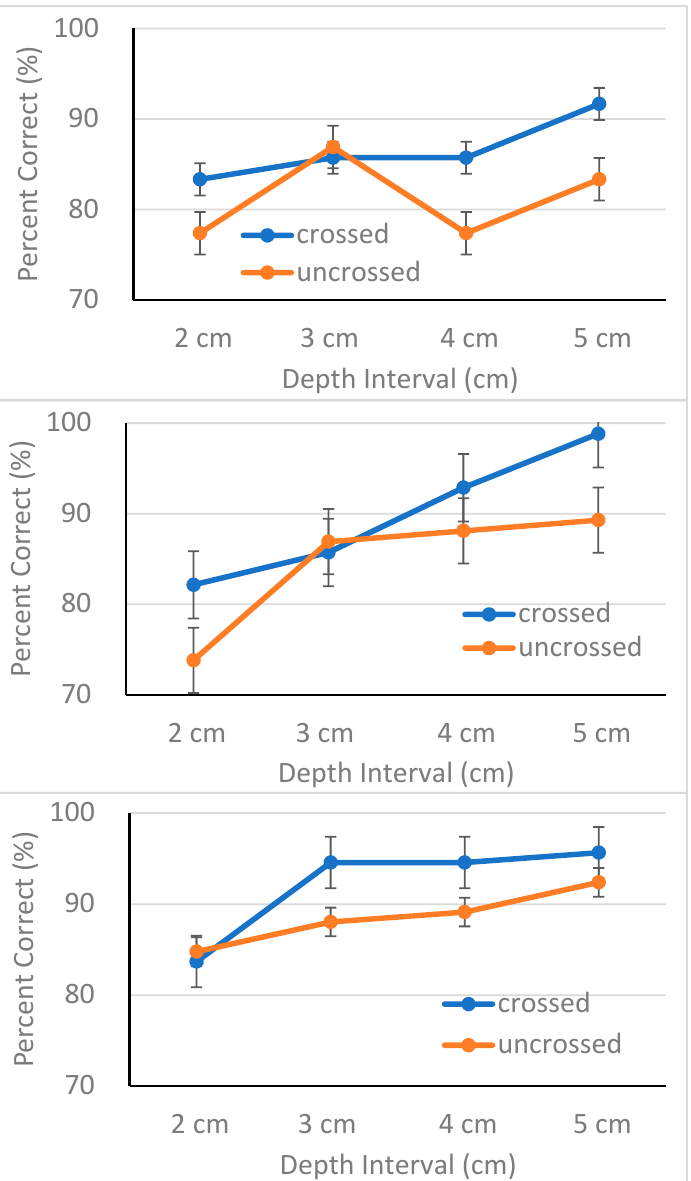
Figure 2. Percent correct (with standard error bars) plotted as a function of depth interval for each condition of disparity direction for elderly controls ( top panel ), AD patients ( middle panel ) and MCI patients ( bottom panel ), respectively.